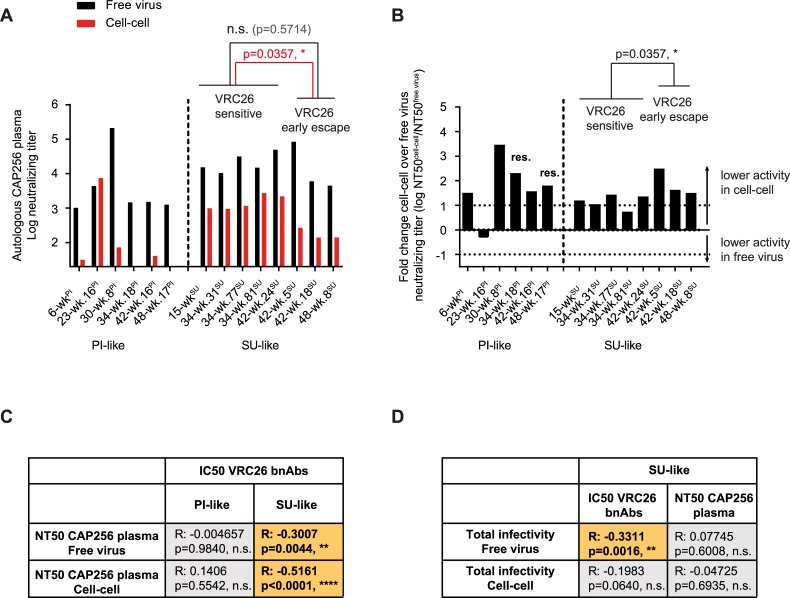
Activity of autologous plasma against cell-cell transmission of CAP256 viruses is strongly driven by VRC26 bnAb activity.A: 50% neutralizing titers (in plasma dilution) of autologous CAP256 plasma from week 145 p.i. against free virus (black) and cell-cell transmission (red) of CAP256 virus strains is depicted. Data are means of 2 to 3 independent experiments. Inhibition of SU-like VRC26 sensitive viruses and SU-like VRC26 early escape viruses in free virus and cell-cell transmission were compared using the Mann-Whitney test. P values are indicated in black and red respectively. B: The change in neutralization activity for cell-cell compared to free virus transmission is shown as the ratio of NT50free-virus/NT50cell-cell (Fold change Neutralizing titer). Zero denotes equal activity in both transmission pathways. A 10-fold higher activity in free virus over cell-cell transmission reflects a log10 = 1, a 10-fold lower activity a log10 = -1 as indicated by dotted lines. Viruses that were not neutralized to 50% at the half lowest plasma concentration were denoted as resistant (res.) and their fold changes were estimated. C: Interrelations of neutralizing titers for plasma and IC50s for bnAb neutralization were determined separately for PI-like and SU-like viruses during free virus and cell-cell transmission. D: Interrelations of virus infectivity in free virus and cell-cell transmission, IC50s and neutralizing titers (NT50) were determined for SU-like viruses. C+D: Spearman correlations on untransformed data sets were used, R and p values are indicated. Orange fields negative correlations. N.s. denotes no significance.